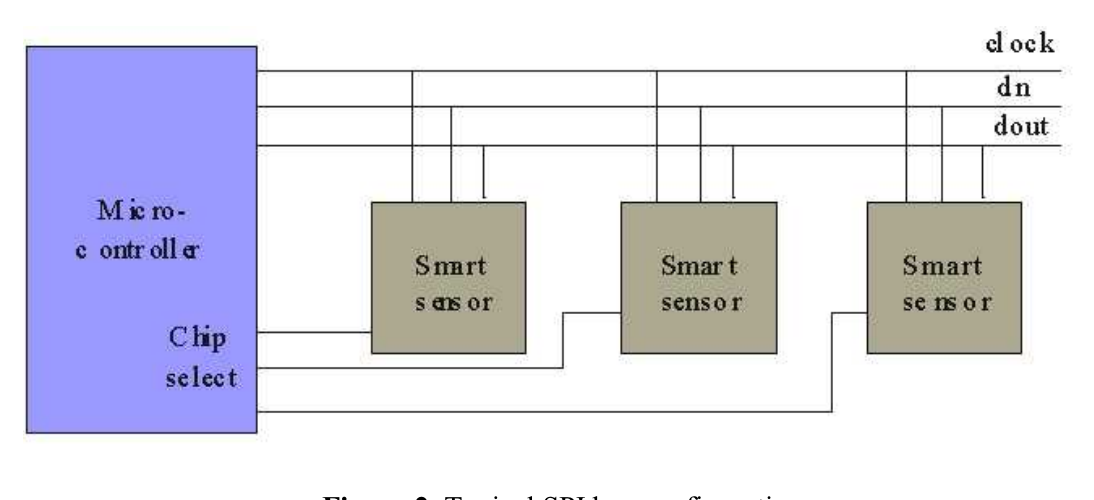
Figure 2 . Typical SPI bus